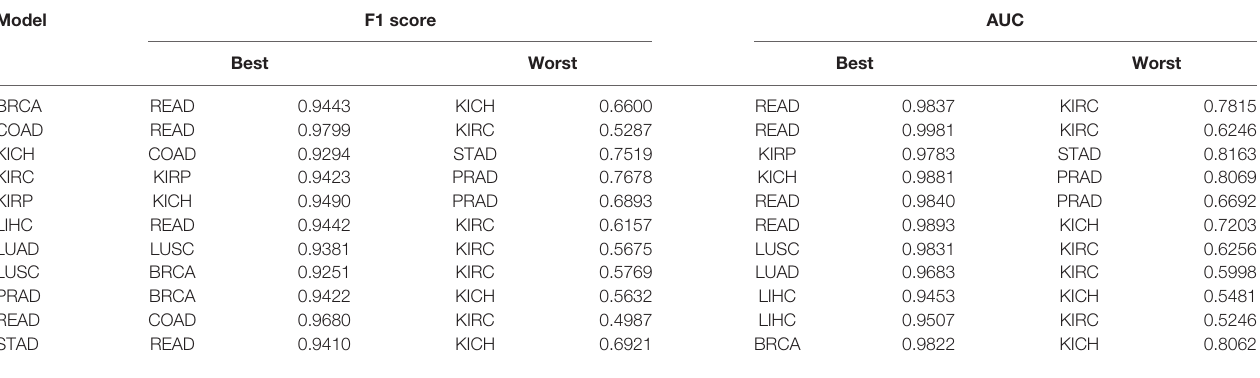
TABLE 1 | Cross-organ inference indicating the quantitative results of best and worst inferences of individually trained models when tested on other unseen organs. Model F1 score